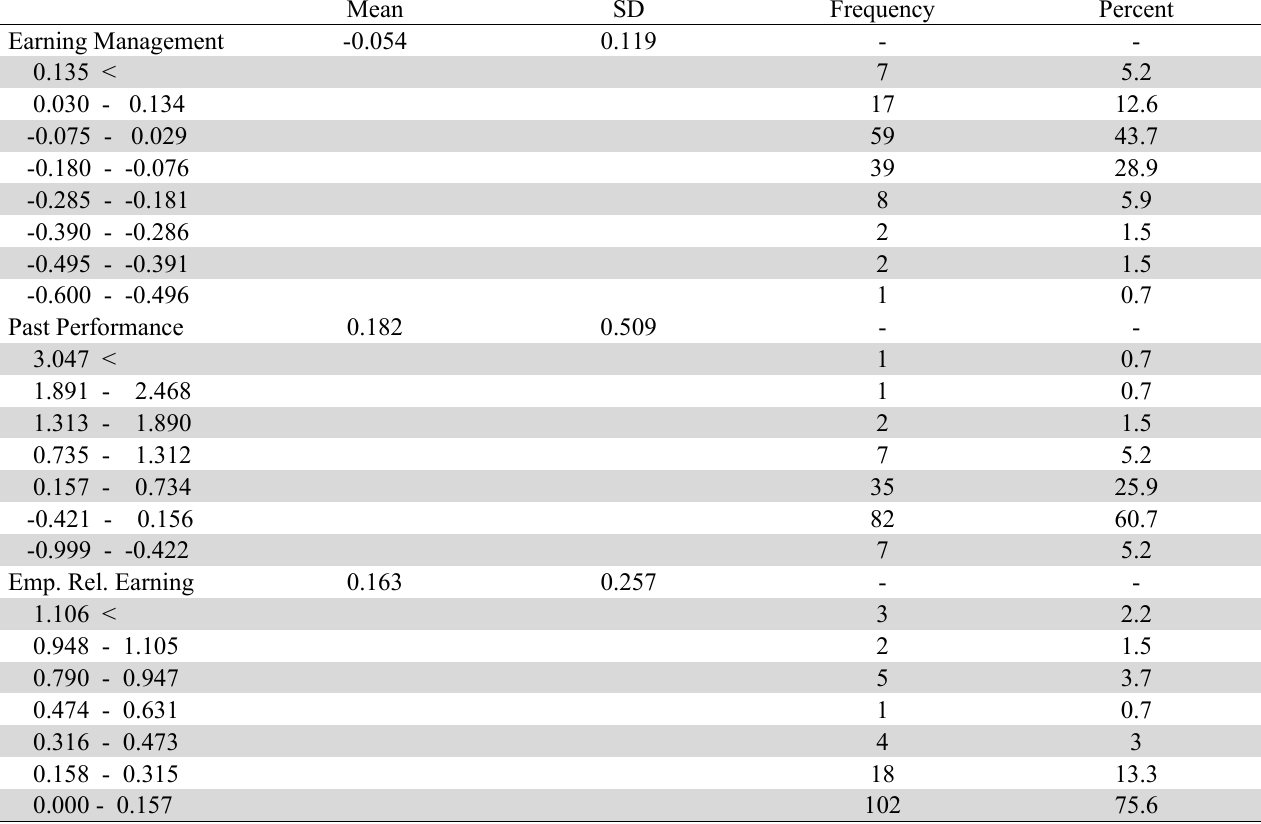
The mean, standard deviation, frequency, and percentage of companies listed in Jakarta Stock Exchange.